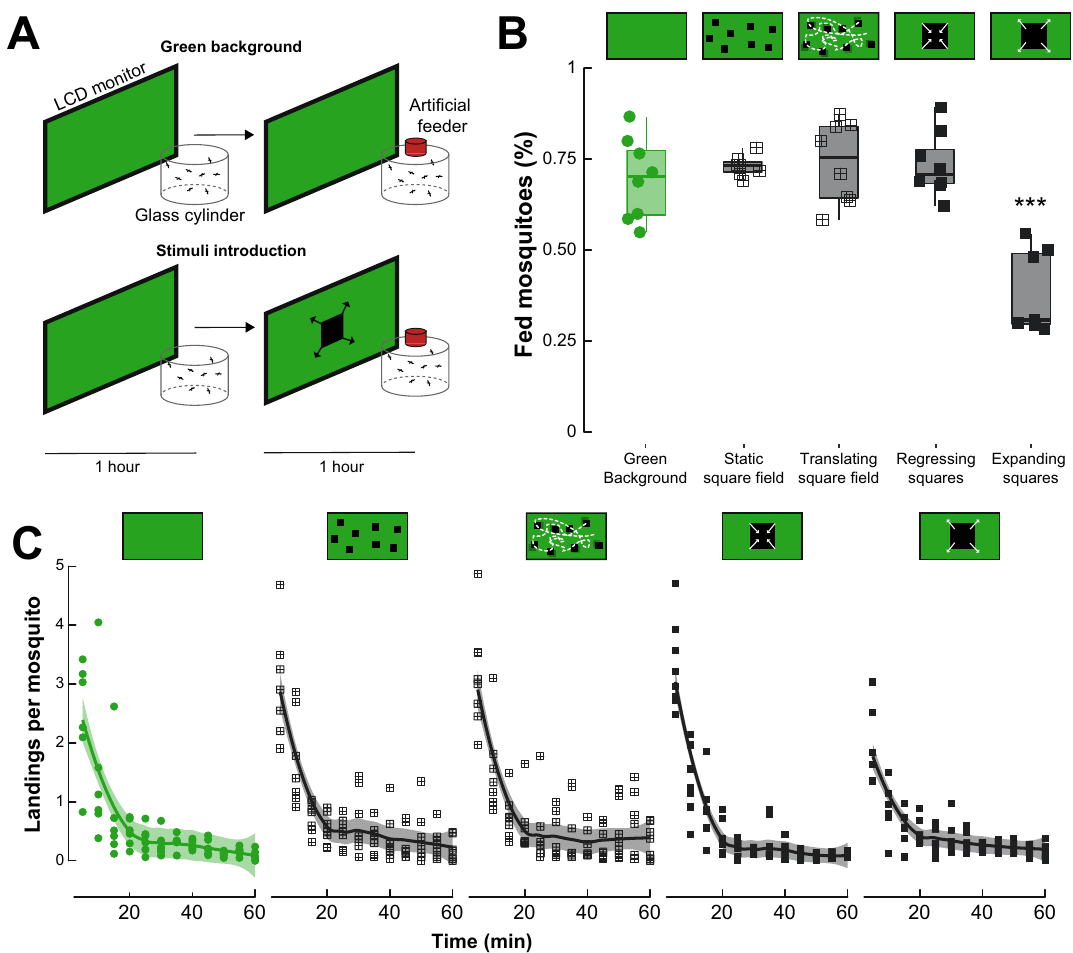
Figure 2. Landing and feeding on a host mimic in different visual contexts. (A) Schematic of the experimental apparatus. Groups of mosquitoes are enclosed in a glass cylinder positioned in front of an LCD monitor. To acclimate to the experimental conditions, mosquitoes are left unperturbed in front of a green background for 1 h. Control groups (top) were exposed to a second hour of green background during which the number of landing and feedings on a membrane feeder were quantified. Treatment groups (bottom) were exposed to randomly positioned squares following the patterns described in ( B,C ). (B) Proportion of feedings quantified at the end of the second hour of the experiment for the control (green, n = 8) and treatment groups (dark grey, crossed squares for square fields, and filled squares for regressing and expanding squares, 7 < n < 8). (C) Number of landings per mosquito quantified every five minutes of the second hour of the experiment for the control (green) and treatment groups (dark grey, crossed squares for square fields, and filled squares for regressing and expanding squares). Asterisks denote significant differences (*** p < 0.001; generalized linear